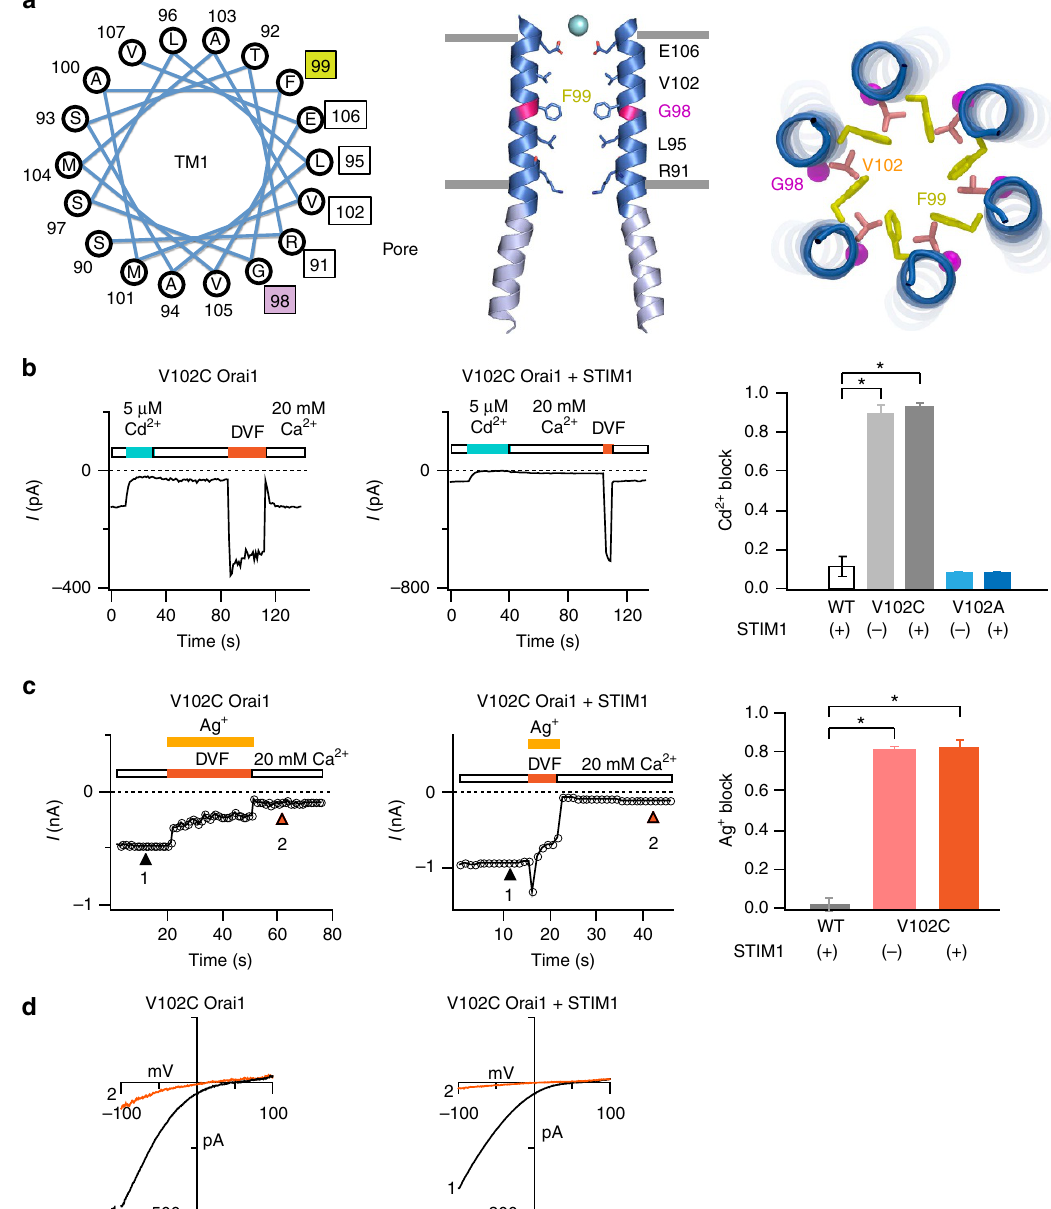
Figure 1 | Cd 2 þ and Ag þ blockade of V102C Orai1 is not modulated by STIM1. ( a ) A helical wheel representation of residues in the TM1 pore helix (top view). Pore-lining residues previously identified through cysteine scanning in the STIM1-gated Orai1 channel 16 , or in the dOrai crystal structure (PDB code ID 4HKR) 10 , are shown in boxed text. F99, whose corresponding residue in dOrai (F171) was found to be pore-lining in the crystal structure, is shown in green, whereas G98, located 100 (cid:2) away is depicted in pink. The cartoons in the middle panel depict side-view of two TM1 helices showing pore-lining residues. A Ba 2 þ ion is shown in blue above the selectivity filter. The cartoon on the right shows the radial positions of V102, F99 and G98 viewed from the top. ( b ) Cd 2 þ (5 m M) blocks V102C Orai1 current to a similar extent in the absence and presence of STIM1. The indicated Orai1 constructs were expressed in HEK293 cells either with or without STIM1 co-expression. The background block in WT and V102A channels is o 10%. N ¼ 8–16 cells for each condition. * ¼ P o 0.001 (Student’s t -test). Values are mean ± s.e.m. ( c ) Ag þ (130nM) blocks V102C Orai1 currents to a similar extent in the presence or absence of STIM1. WT Orai1 channels are not affected by Ag þ (Supplementary Fig. 1), but the introduction of cysteine at V102 confers sensitivity to Ag þ blockade. Blockade by Ag þ was measured by comparing current amplitudes in 20mM [Ca 2 þ ] 0 before and following Ag þ administration (arrowheads). N ¼ 4–5 cells for each condition. * ¼ P o 0.001 (Student’s t -test). Values are mean ± s.e.m. ( d ) Ag þ blockade does not alter the current–voltage ( I – V ) relationship of Orai1. I – V s were obtained at the time points indicated by the arrowheads in c